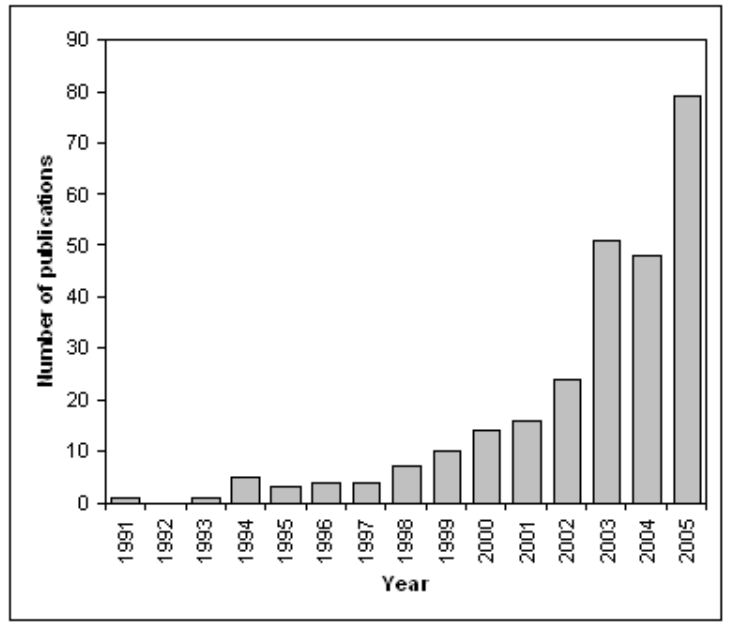
FIGURE 1. A crude estimate of publications that reports docking into homology models (excluding protein-protein docking). The figure was generated after searching